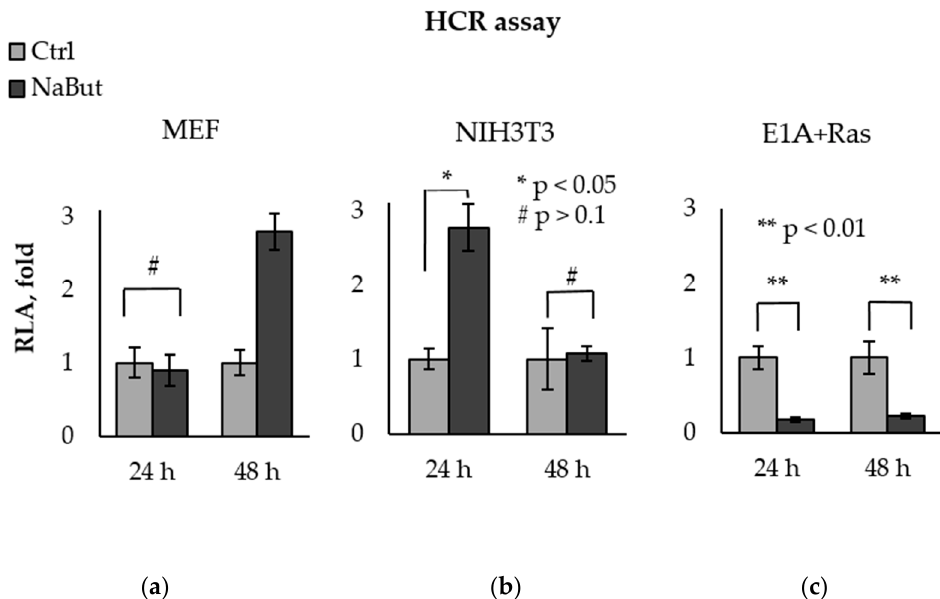
Figure 3. NaBut inhibits the repair of exogenous DNA in transformed cells. Host cell reactivation of transcription of the endonuclease-damaged pGL3-Luc in MEF ( a ), NIH3T3 ( b ), and E1A+Ras cells ( c ). Cells were transfected with intact or damaged pGL3-Luc vector and incubated without NaBut (Ctrl, light gray) or with (NaBut, dark gray) for 24–48 h. The relative luciferase activity (RLA) corresponding to the DNA repair efficiency was calculated as the luciferase activity in cells transfected with damaged plasmid. RLA values were scaled to the RLA of untreated cells (folds). The bar plots show the average value of the RLA ± SEM from 3 or 4 independent experiments.